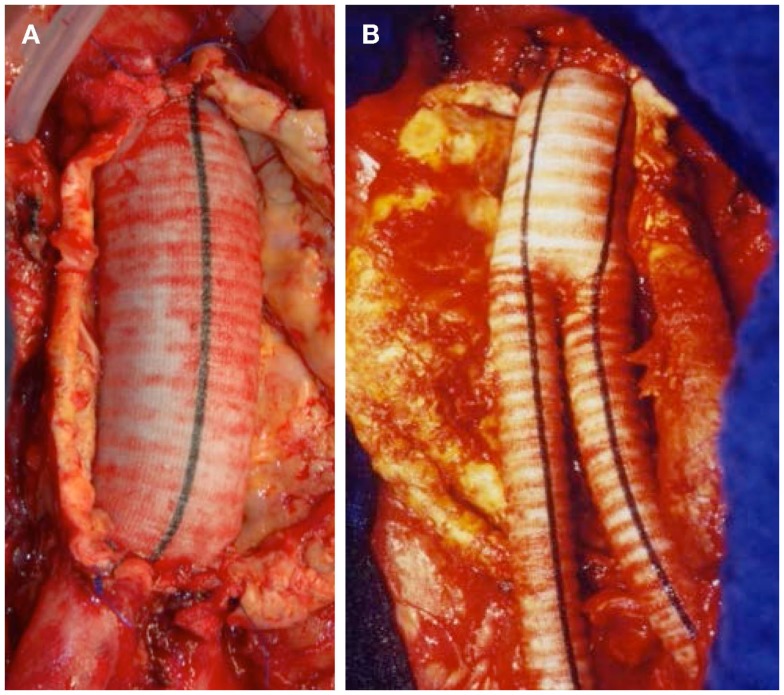
(A) Successful exclusion of an infrarenal AAA by a tube graft. Iliac bifurcation intact. (B) Successful exclusion of an infrarenal AAA by a bifurcated stent graft.